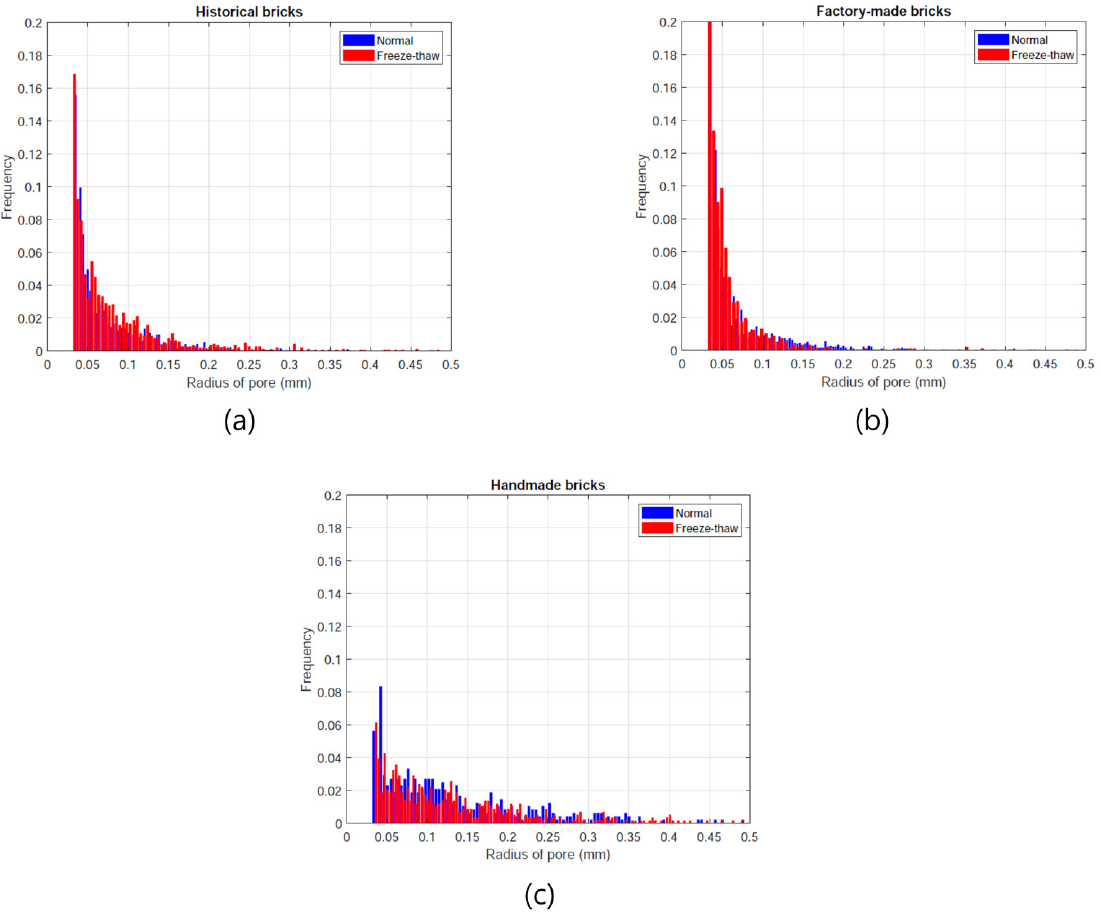
Figure 7. Pore size distributions of each case ( a ) historical bricks, ( b ) factory-made bricks, ( c ) handmade bricks (Note: in each figure, the blue denotes the pore size distribution in the normal state, while the red is the size distribution after freeze-thaw cycles.).